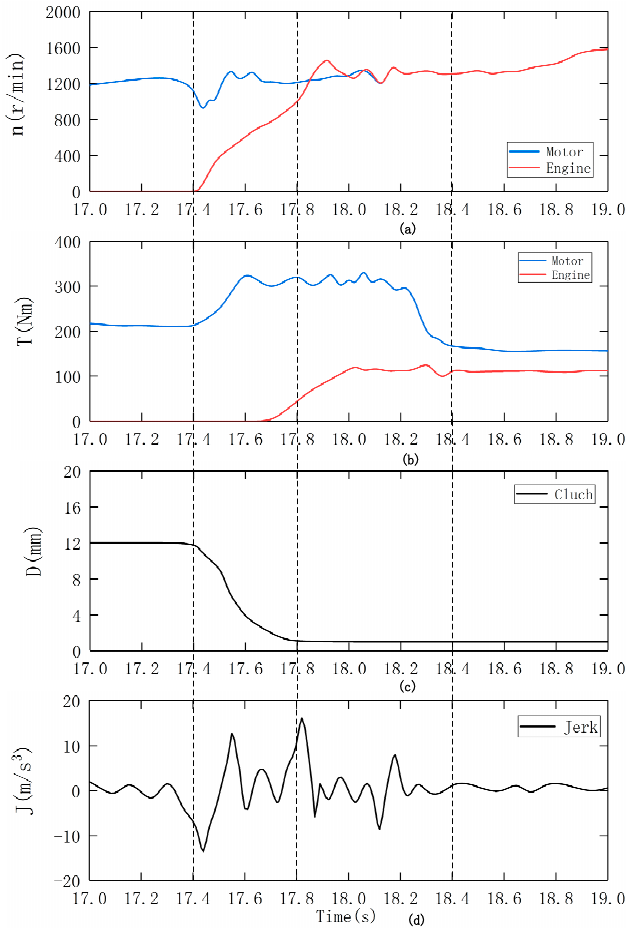
Figure 11. Results of the traditional method. ( a ) speeds of the engine and motor; ( b ) torques of the engine and motor; ( c ) displacement of the clutch; ( d ) jerk of the driveline.